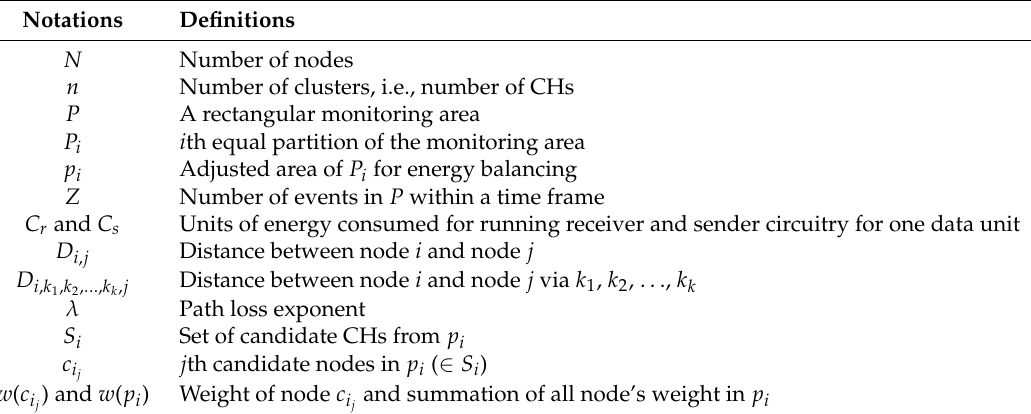
Table 1. Notations and their